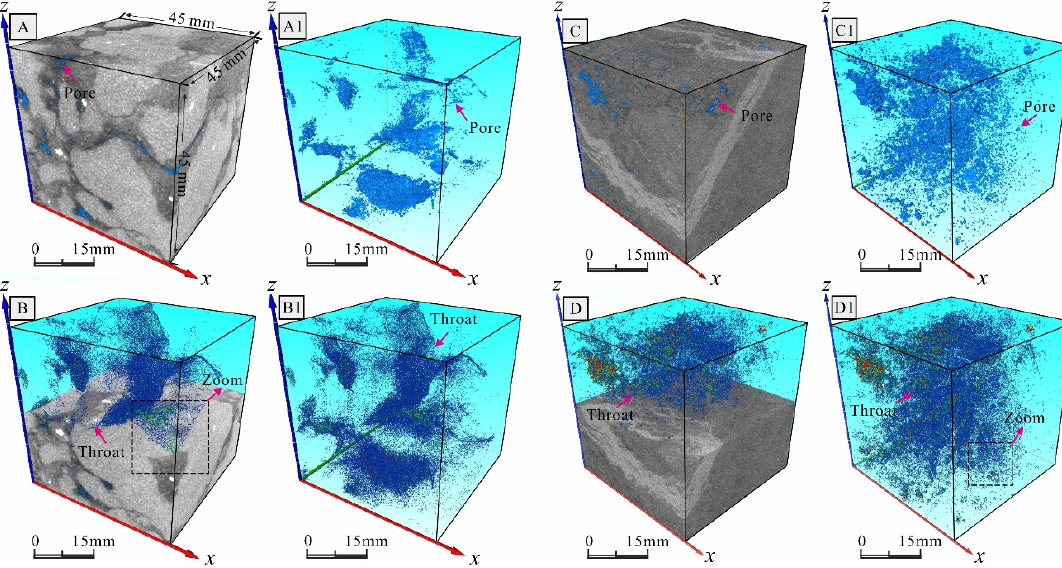
Figure 6. CT scan images of pore and throat radius distribution of the selected samples. ( A ) Sample B’ pore; ( B ) Sample B’ throat; ( C ) Sample E’ pore; ( D ) Sample E’ throat.